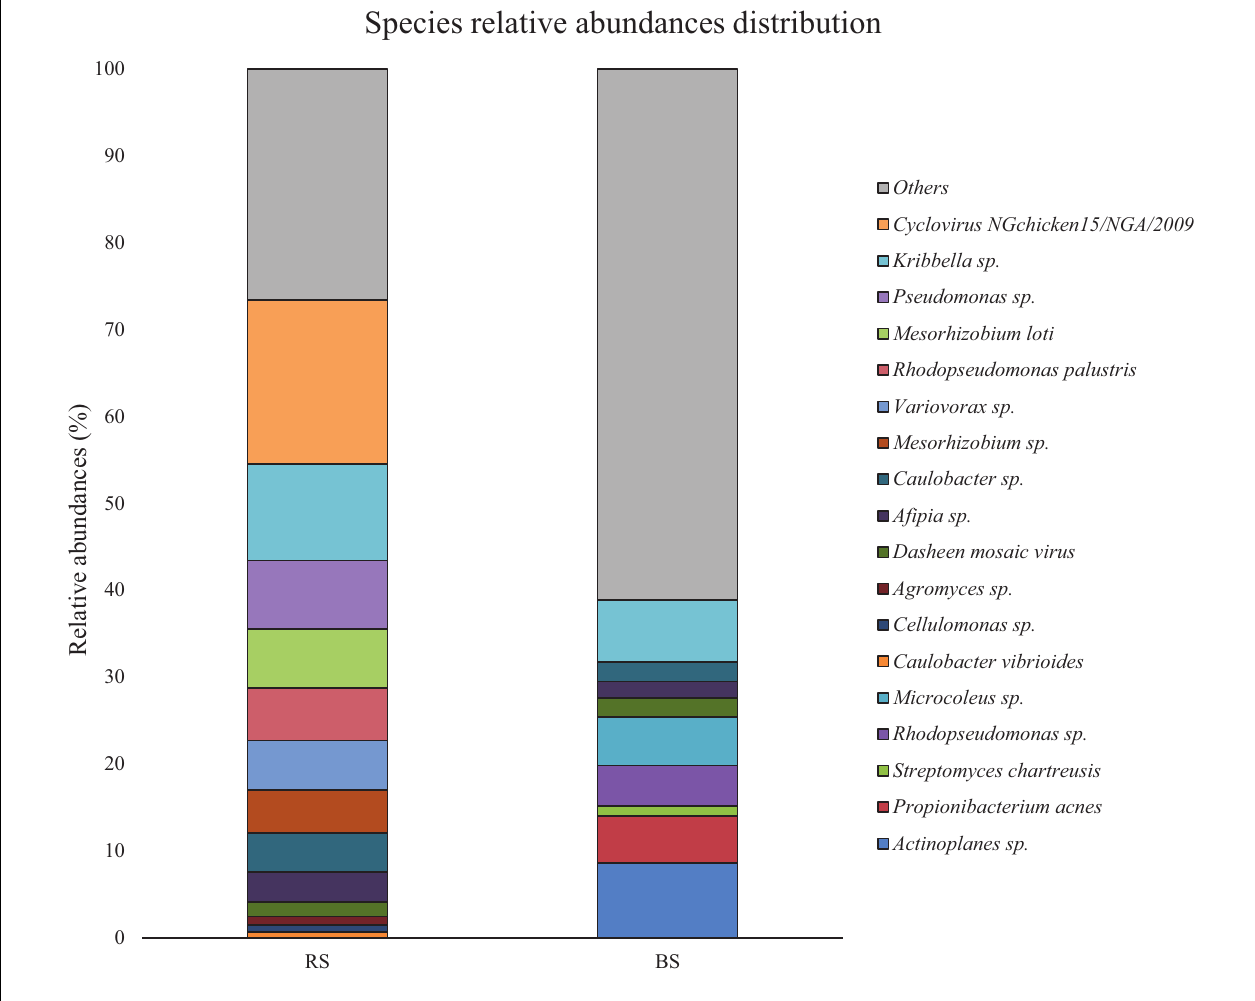
FIGURE 2 | Comparative of the population relative abundances by taxonomic level of species in RS and BS. A pool of species could not be identifided with the sequences present in the metagenome in both